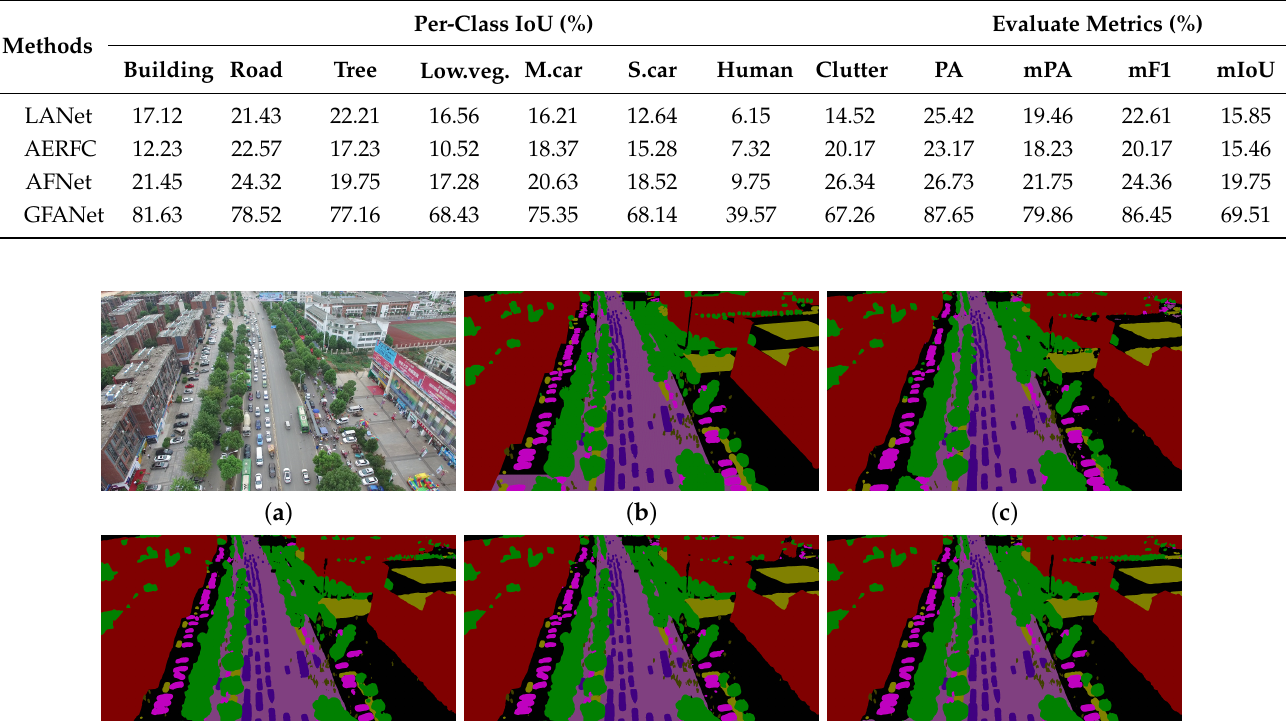
Table 2. Comparison of evaluation metrics on adversarial example test set in the UAVid dataset.